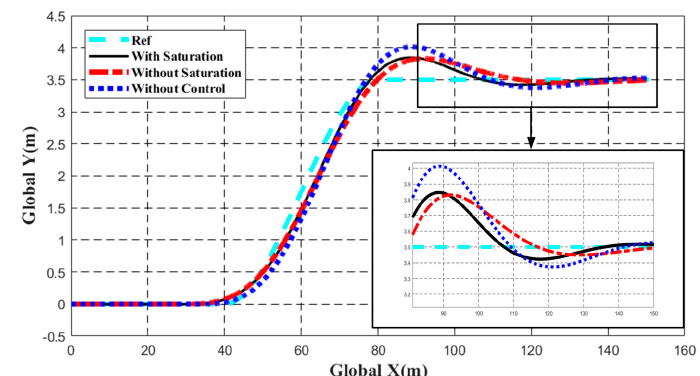
Energies 2020 , 13 , x FOR PEER REVIEW Figure 7. The simulation results for the global trajectories. Figure 7. The simulation results for the global trajectories.